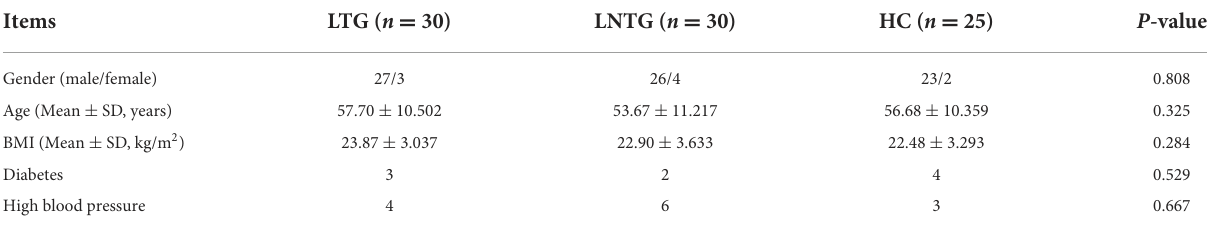
TABLE 1 Demographic characteristics of the three groups.